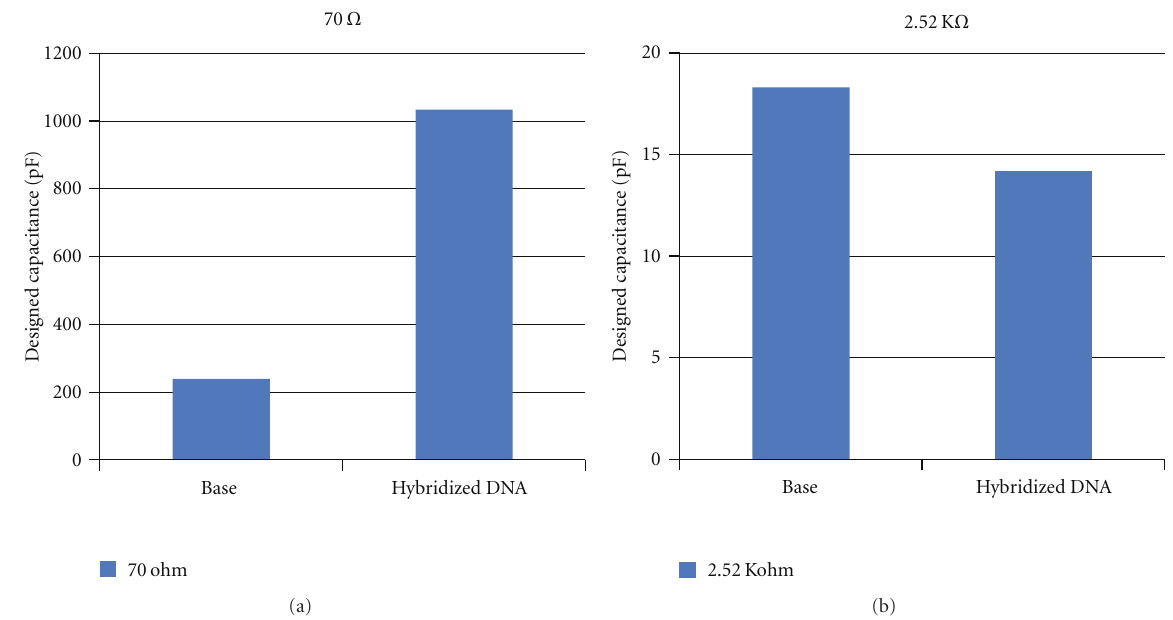
Figure 9: (a) Designed capacitance change from BASE to hybridized DNA for sensor having 70 Ω bare resistance. (b) Designed capacitance change from BASE to hybridized DNA for sensor having 2.52 K Ω bare resistance.